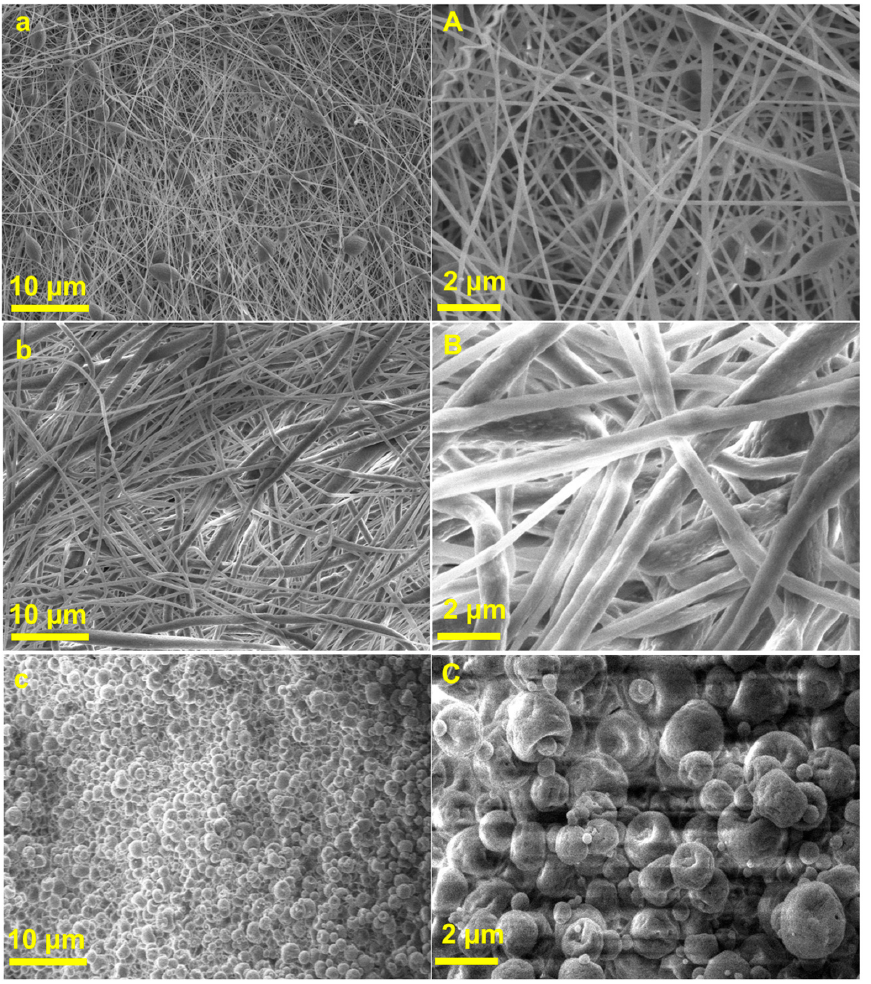
Figure 1. SEM images of ( a , A ) PLA25, ( b , B ) PLA 35 and ( c , C )PLA45 PEG/PLA films with the magnification of ( a – c ) 5000 × and ( A – C ) 20,000 × .